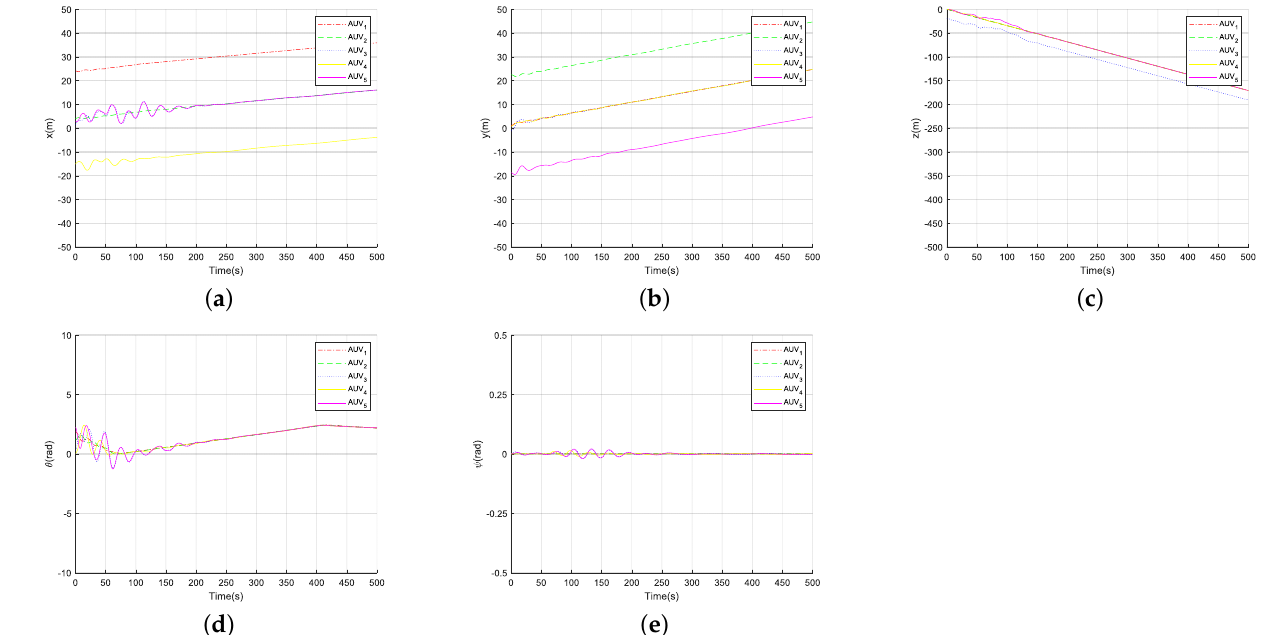
(a) The x state of multi-AUV Figure 4. The position state of the multi − AUV formation: ( a ) the x state of multi − AUV, ( b ) the y state of multi − AUV, ( c ) the z state of multi − AUV, ( d ) the θ state of multi − AUV, ( e ) the ψ state of multi −